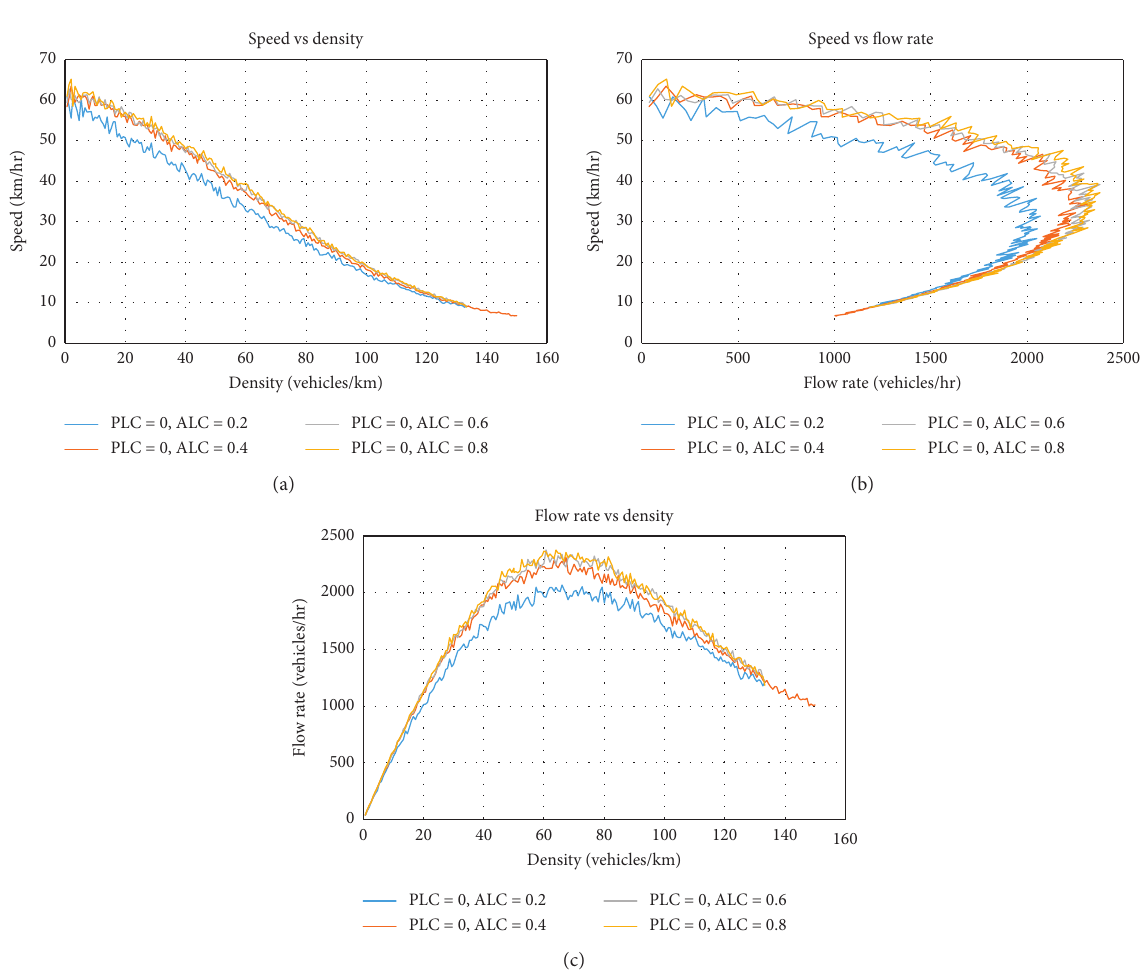
Figure 7: Traffic flow fundamental diagrams for different compositions of AC, MC, AB, and MB with different values of ALC when PLC is fixed at